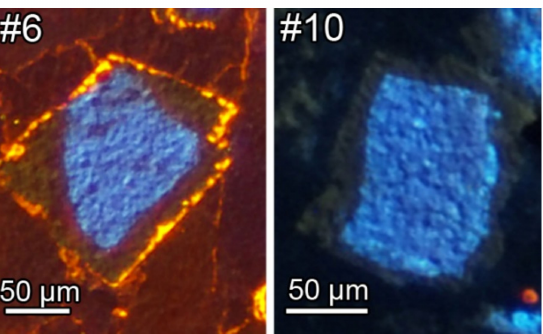
Figure 5. Detail of a K-feldspar grain under CL (cyan) in tesserae #6 and #10. They both show recognizable authigenic overgrowths (dark brownish blue), additionally, in tessera #6 there is also a rim of carbonatic cement (bright